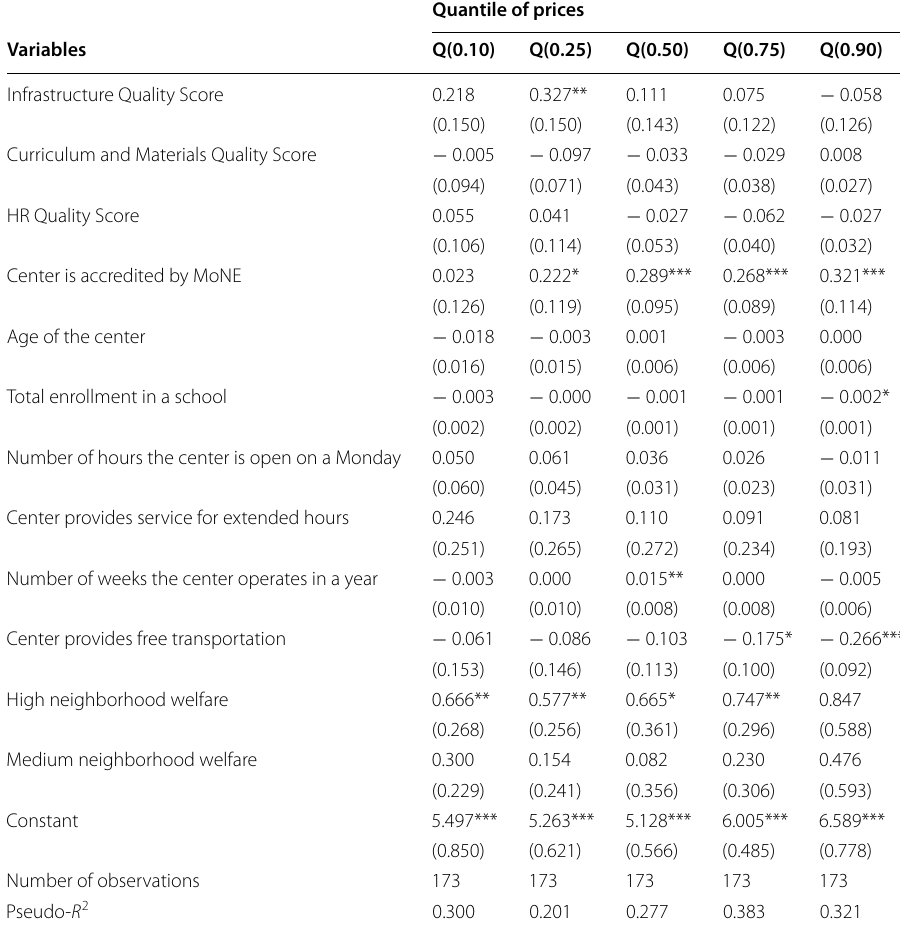
Table 4 Quantile regression results for the price